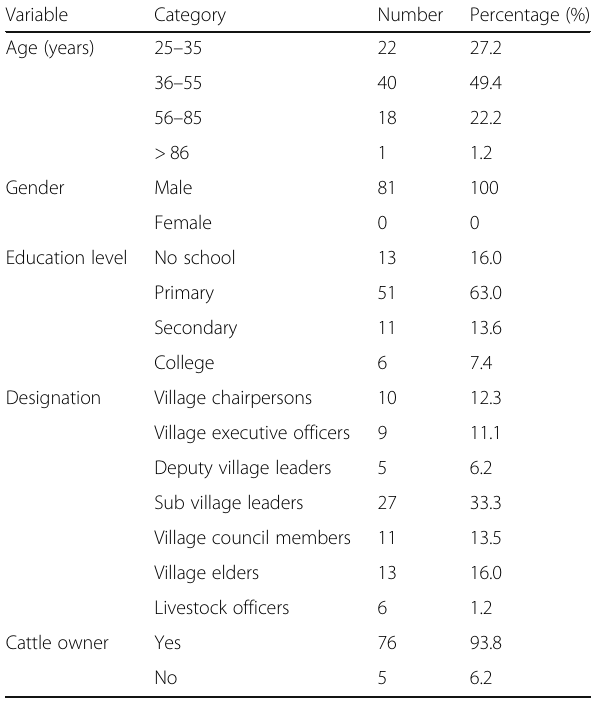
Table 2 Demographic characteristics of FGD participants ( N = 81) in ten villages of Monduli District, Northern Tanzania in